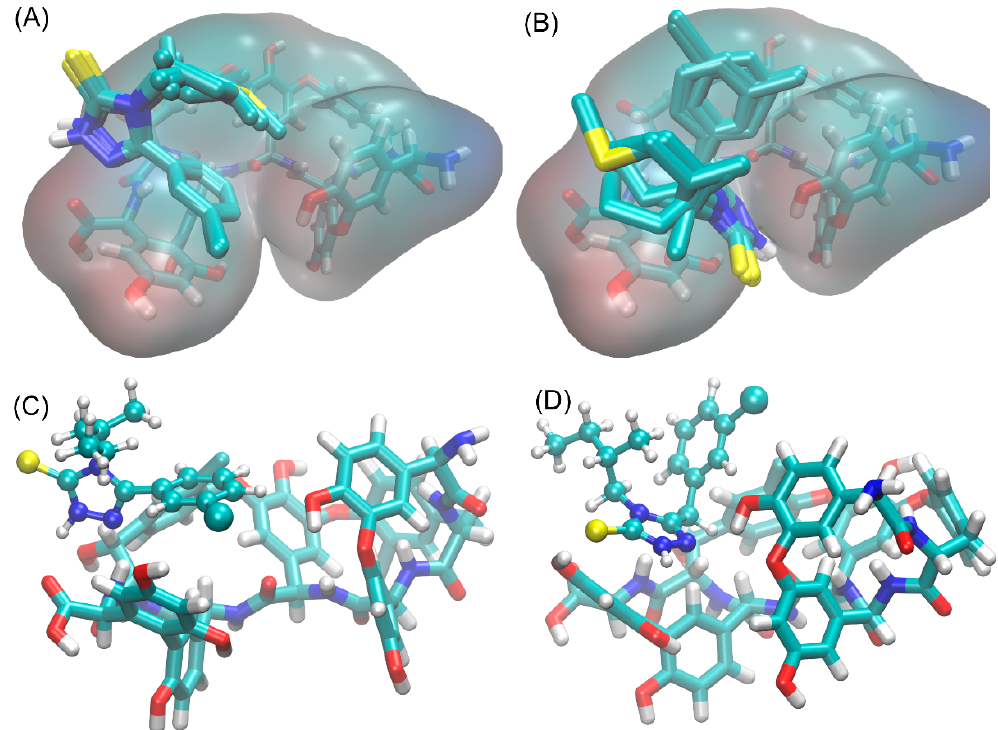
Figure 9. ( A , B ) Graphical illustration of the docking results. The two groups of ligands are considered separately, i.e., those that either do ( A ) or do not ( B ) contain a methylene group between triazole and phenyl rings. The pictures show the identified locations of the ligand molecules (stick representation) interacting with teicoplanin (stick plus surface representation). ( C , D ) Graphical illustration of the DFT-optimized structures of complexes, shown on the example of the TRP-10 ( C ) and TRP-26 ( D ) compounds. The ligands are shown in the ball-and-stick representation. As identified by the docking study, the binding pattern exhibited by the first group of compounds is characterized by the close contact of the ligand chlorophenyl group with the dihydroxy phenyl moiety of teicoplanin. The parallel arrangement of these two rings indicates the presence of π - π interactions. At the same time, the triazole ring is rotated by about 60 deg with respect to the phenyl ring and maintains close contact with aliphatic and aromatic hydrogen atoms that belong to the hydroxyl methylene and chlorophenyl groups of teicoplanin, respectively. The arrangement of those contacts speaks for the presence of the attractive H- π stacking interactions. The remaining part of the ligand molecule (i.e., the − R substituent) does not exhibit any close contacts with teicoplanin but rather tends to create intramolecular interactions with the chlorophenyl group.